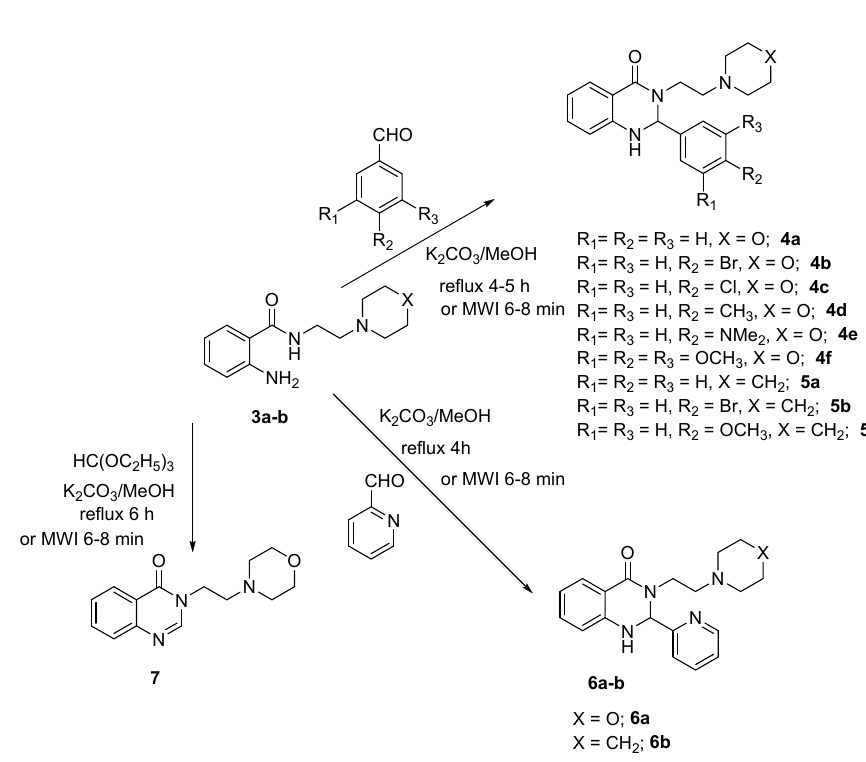
Figure 4. Structure of 4a.